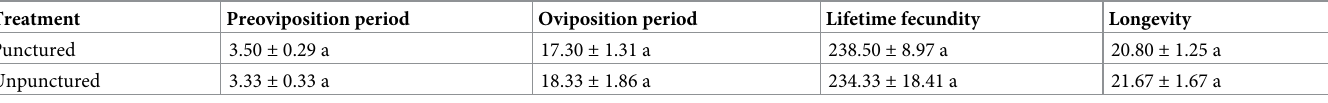
Means within a column with different letters are significantly different ( P <